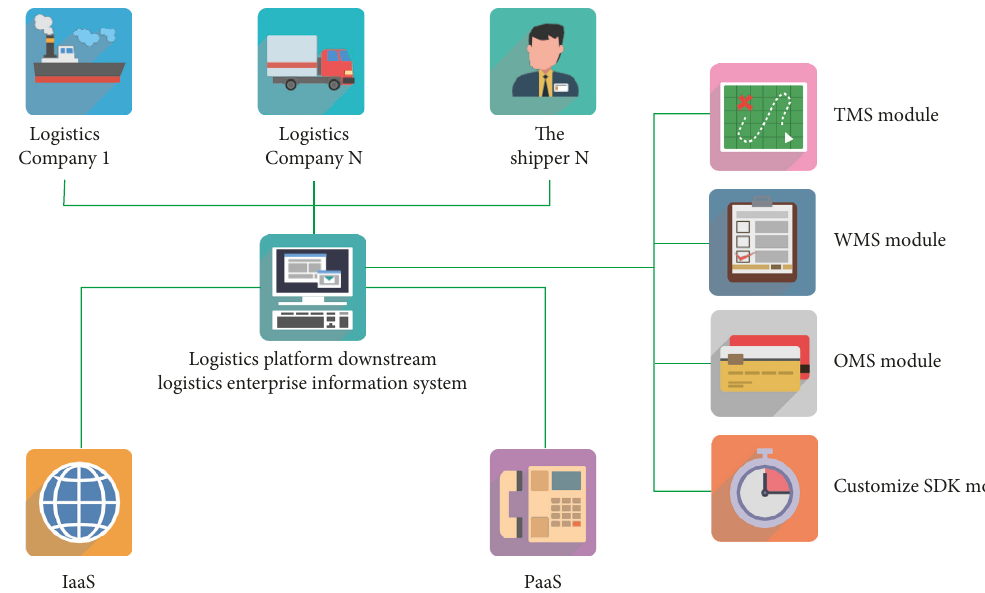
Figure 1: The logistics management system and process based on cloud